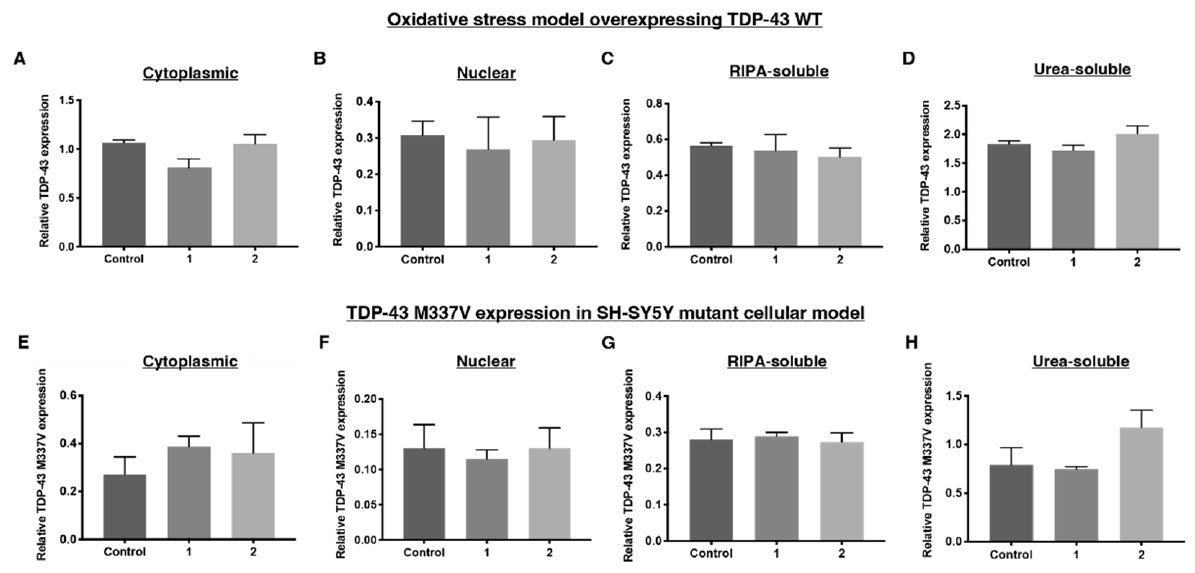
Figure 8. Relative TDP-43 WT expression levels after treatment with 1 and 2 as determined by Western blots. ( A ) Relative TDP-43 WT expression in the cytoplasm, ( B ) nucleus, ( C ) RIPA-soluble fraction and ( D ) urea-soluble fraction after the oxidative stress HEK-293 cellular model, featuring TDP-43 overexpressing HEK-293 cells treated with tetracycline (2 ug/mL, 48 h) and sodium arsenite (15 µ M, 18 h), which was exposed to 1 and 2 . Relative TDP-43 M337V-V5 expression levels in the ( E ) cytoplasm, ( F ) nucleus, ( G ) RIPA-soluble fraction and ( H ) urea-soluble fraction from SH-SY5Y TDP-43 M337V mutant cellular model after treatment of 1 and 2 . Both cell lines were treated with 1 and 2 (300 nM) for 18 h. Densitometry of TDP-43 WT and M337V are normalised to α -tubulin for the cytoplasmic, RIPA-soluble and urea-soluble fraction and lamin B1 for the nuclear fraction. Data represent mean ± SD, n ≥ 3. Significant differences were indexed using a one-way ANOVA with Dunnett’s post hoc test.